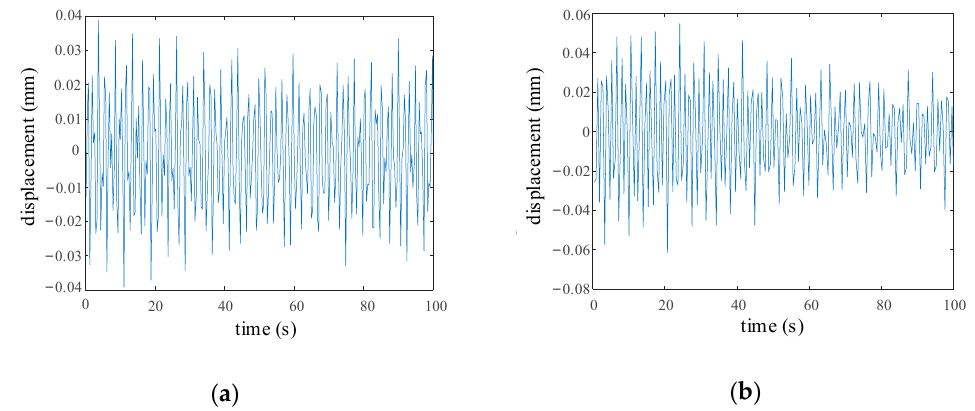
Figure 9. The time domain response of the carrier in the third stage under different loads. ( a ) Vertical displacement Y c3 of the carrier under 50% load; ( b ) vertical displacement Y c3 of the carrier under 150% load.